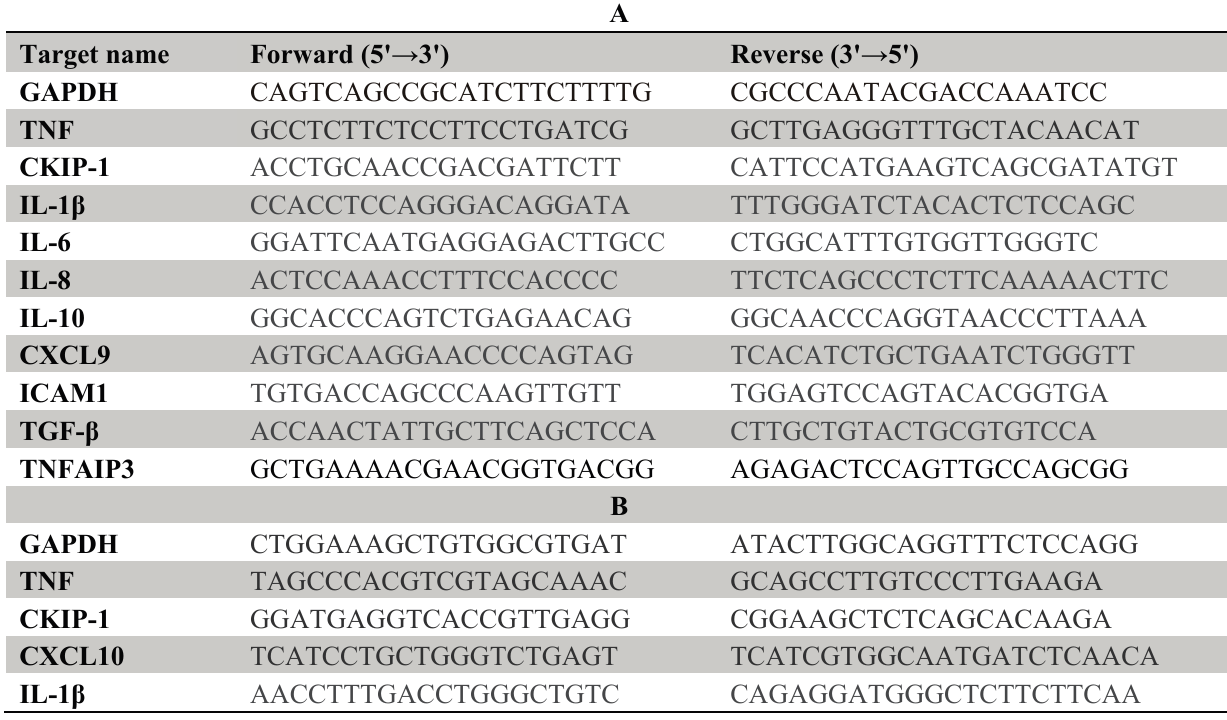
Table 1. Specific exon–exon spanning primer sets used in QRT-PCR experiments. ( A ) human; ( B ) mouse. (Expression of a number of other genes was also investigated; here primers of only those genes that are discussed in this paper are